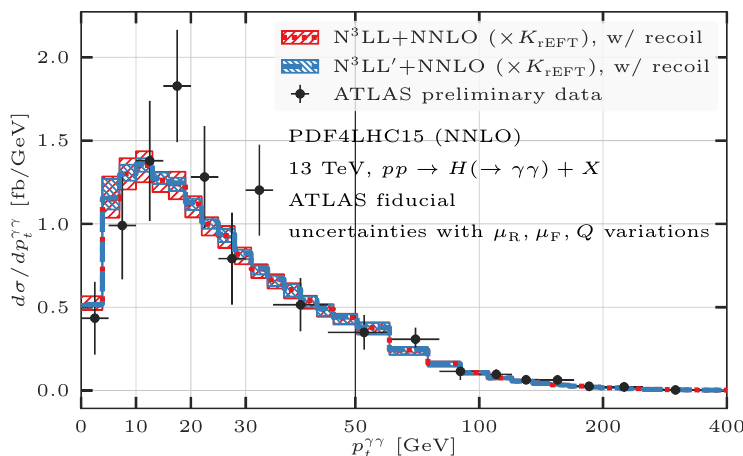
Figure 8 . ATLAS data [98] against matched predictions at N 3 LL+NNLO (red) and N 3 LL 0 +NNLO (blue) for the fiducial p γγ spectrum. Theoretical predictions are rescaled by K rEFT = 1 . 06584 . The t x axis is linear up to p γγ = 50 GeV and logarithmic t